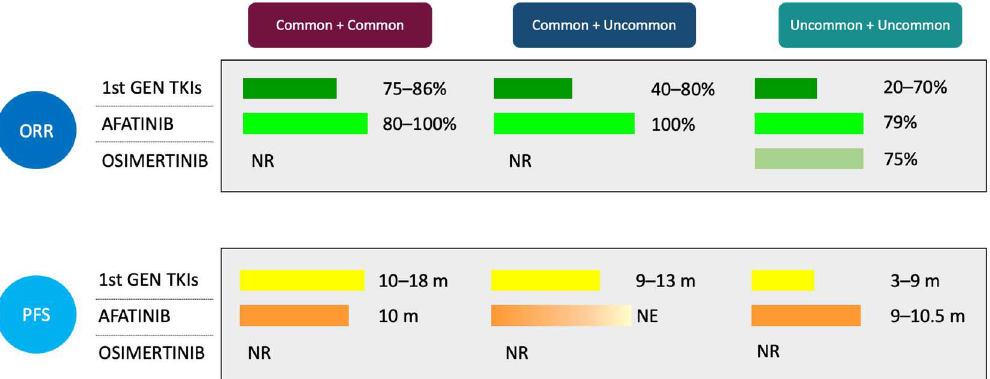
Figure 3. Clinical outcomes of compound EGFR mutations with different EGFR TKIs; de novo T790M compound mutations are excluded. NR: not reported. NE: not estimable.